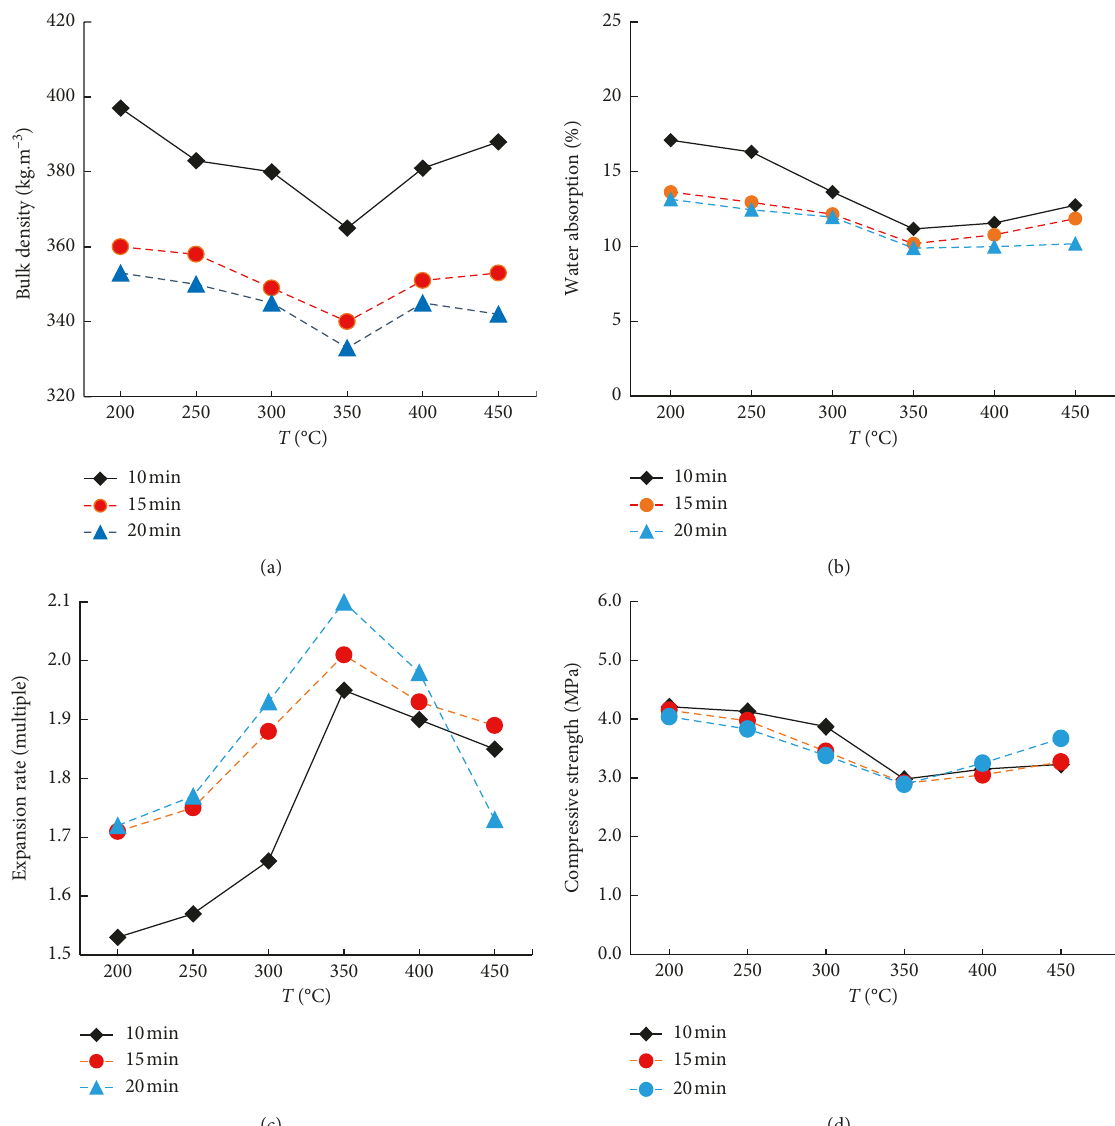
Figure 3: Effect of the preheating system on the performance of ceramsite. (a) Bulk density-temperature curve; (b) water absorption- temperature curve; (c) expansion rate-temperature curve; (d) compressive strength-temperature